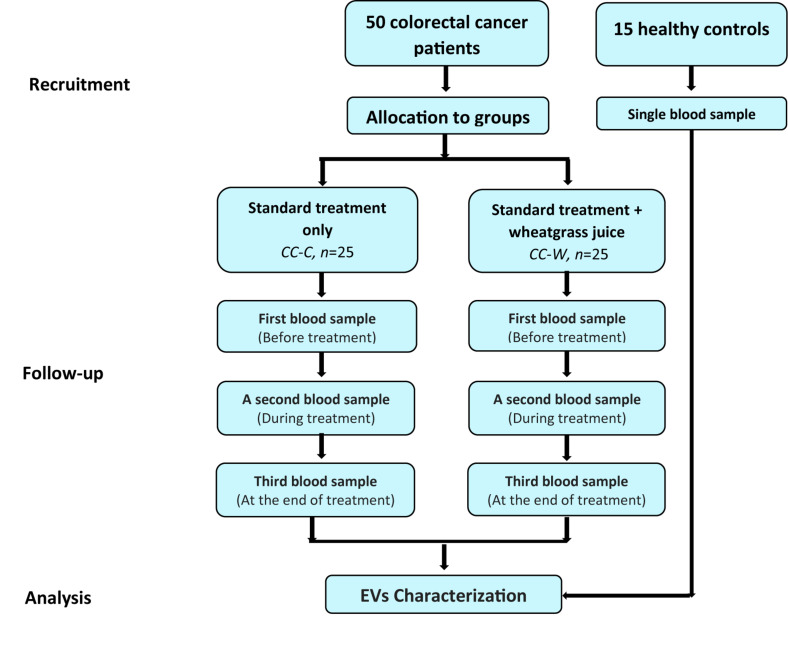
Study design flow chart. Patients diagnosed with colon cancer at stages II–III toward adjuvant chemotherapy following curative surgery. Patients who were interested in participating were admitted to the WGJ (CC-W) group. Blood samples were collected from CC-W and from non-WGJ patients, following consent. Blood samples were obtained at three time points: before first chemotherapy (time point I – BT), after 3 months of chemotherapy (time point 2), and at the end of chemotherapy administration (time point 3). One blood sample was collected from each healthy control (HC). PPP EVs were analyzed.